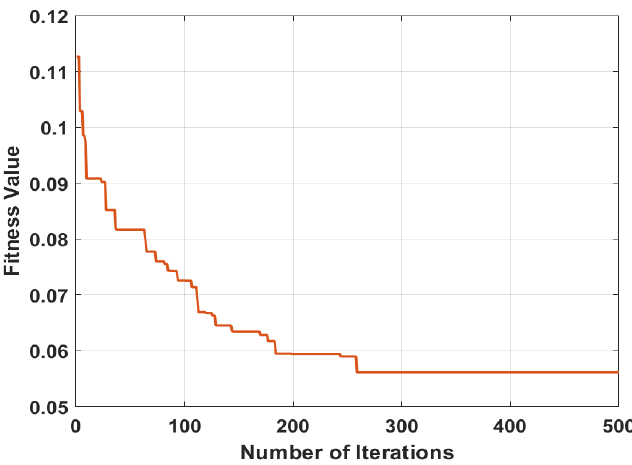
Figure 4. Best selected features using